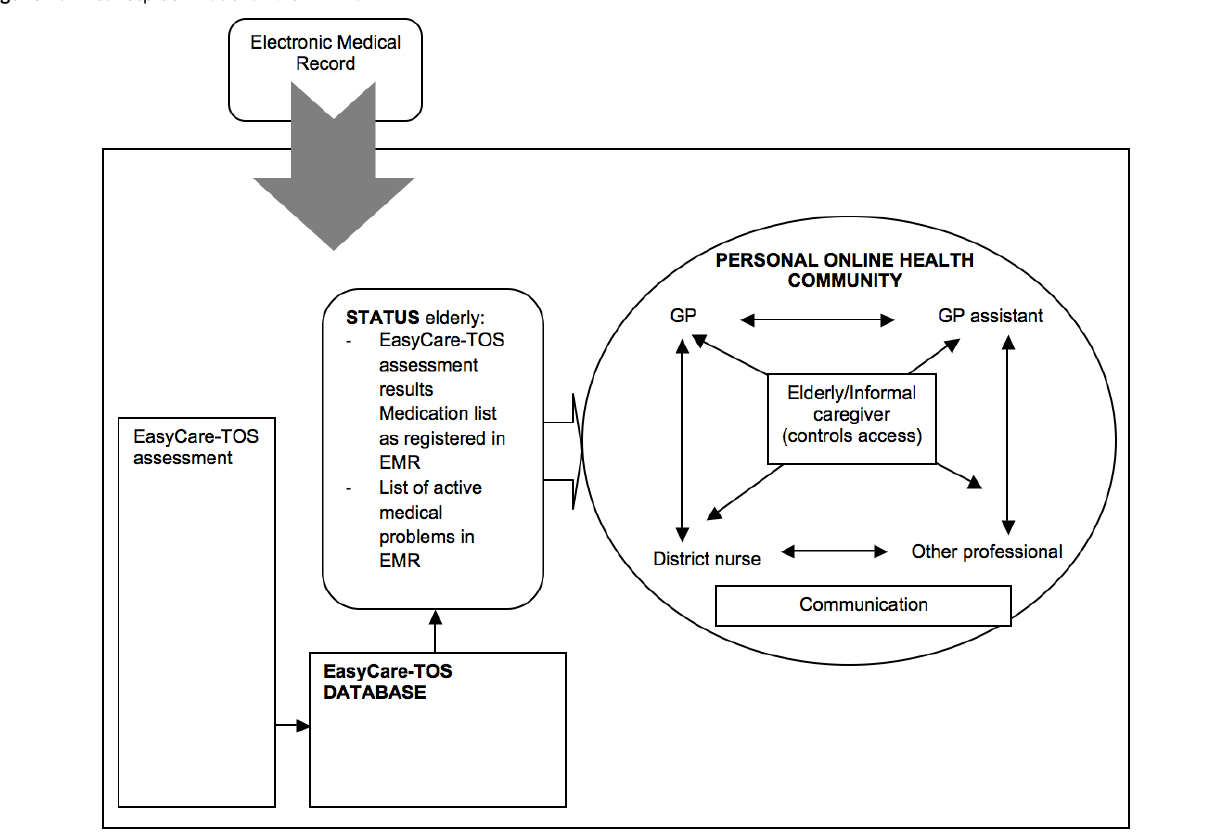
Figure 1. A conceptual model of the